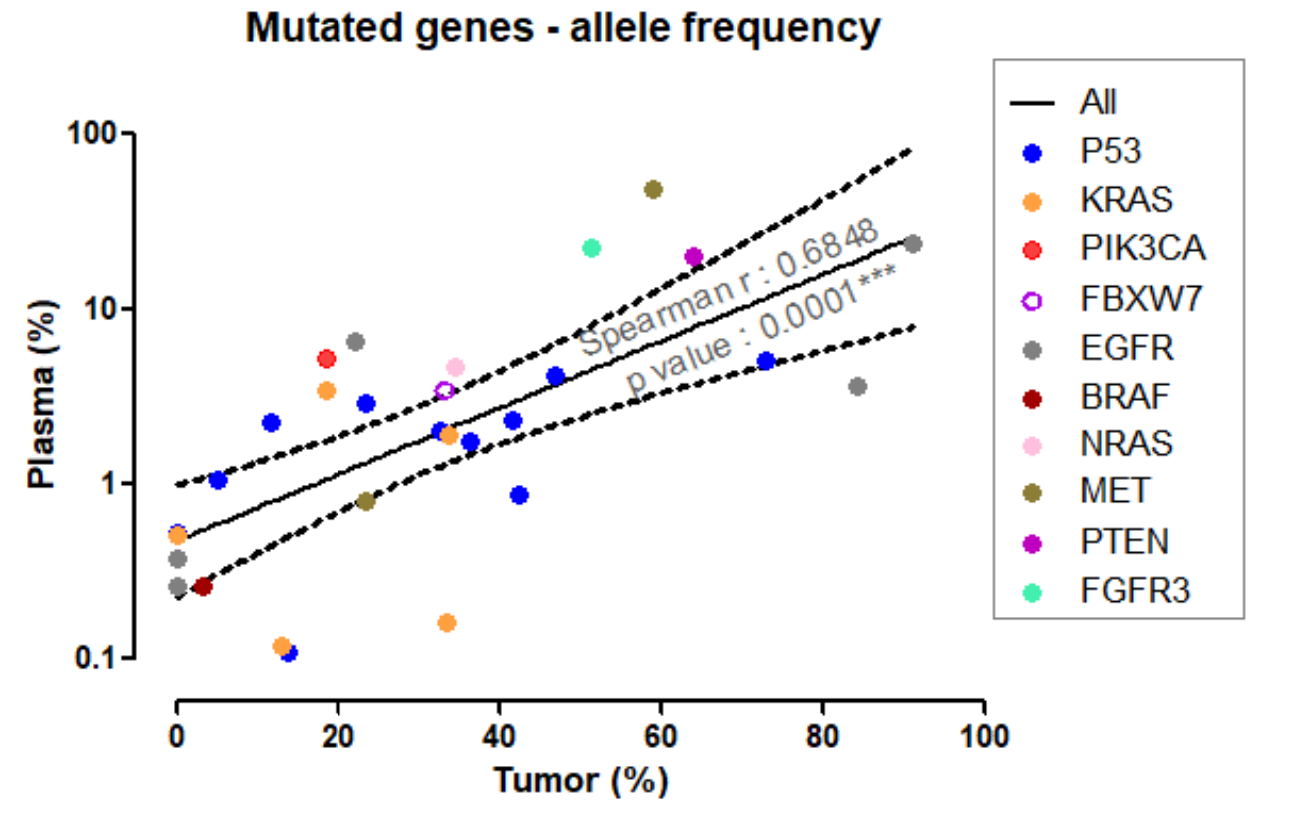
Figure 3. Correlation between plasma and tumor allele frequency. As plasma allele frequency followed a log-normal distribution, these data were log10-normalized, while the tumor values, passing the Kolmogorov–Smirnov normality check, were used as a percentage. The solid line represents the linear regression best fit, dashed lines show the 95% confidence interval. The slope deviated significantly from zero, with a p -value < 0.0001.